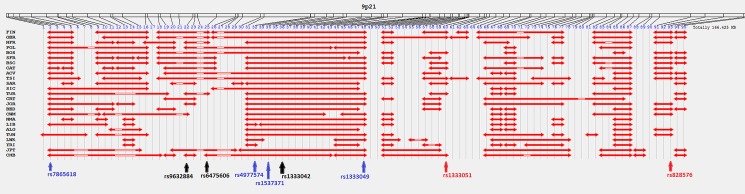
LD blocks for the region 9p21 in 26 populations from Europe, Africa and Asia.Markers previously associated with CAD only in Europe are highlighted in blue, in Caucasians together with African Americans and Chinese in black and in North Africa in red.